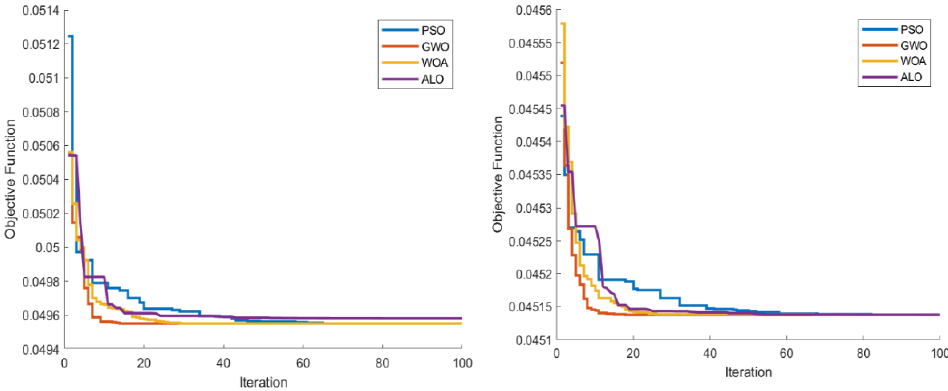
Figure 10. Convergence curves for PSO, GWO, WOA, and ALO using Model I.